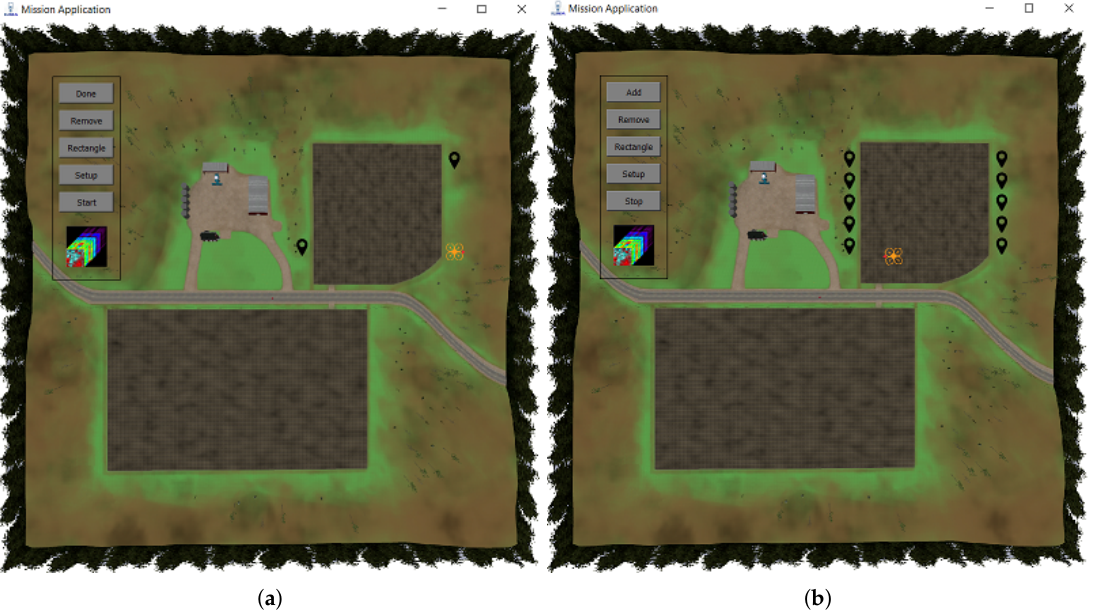
Figure 9. Mission control application window built over the simulation environment map layout. ( a ) Selection of corner waypoints; ( b ) waypoints